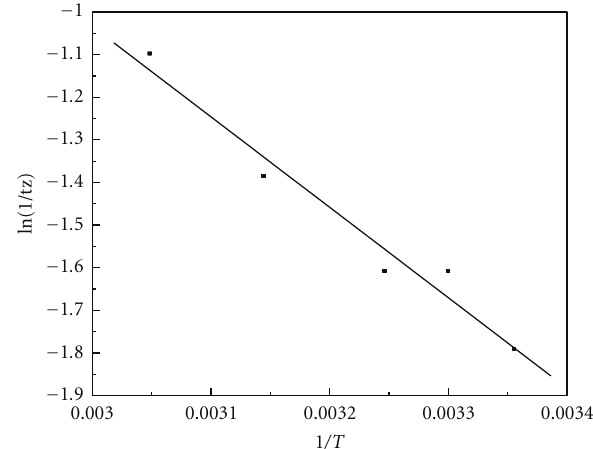
substituted keto isomer of keto-enol